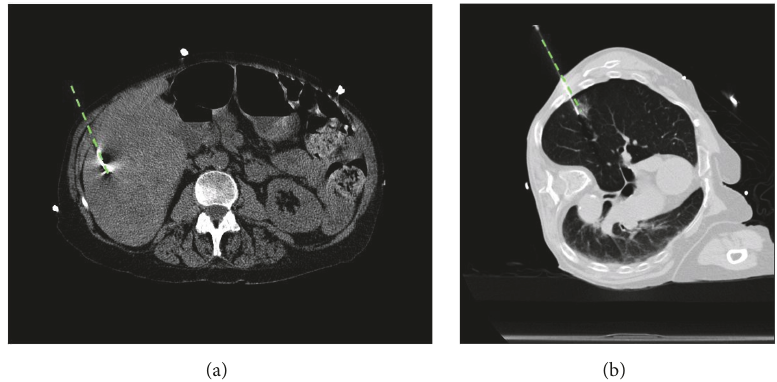
Figure 3: Sample of final confirmation CTs showing the actual needle positions and needle positions projected by the navigation system (dashed lines). (a) Patient abdominal scan; (b) patient thoracic